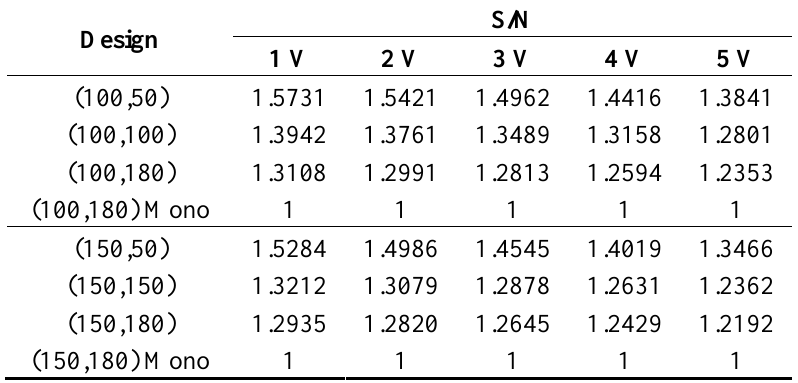
Table 5. Normalised S/N ratio for different ( l , l